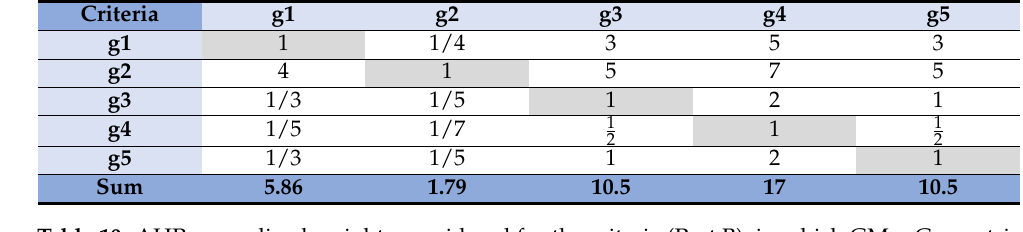
Table 10. AHP normalized weights considered for the criteria (Part B), in which GM = Geometric mean CR =